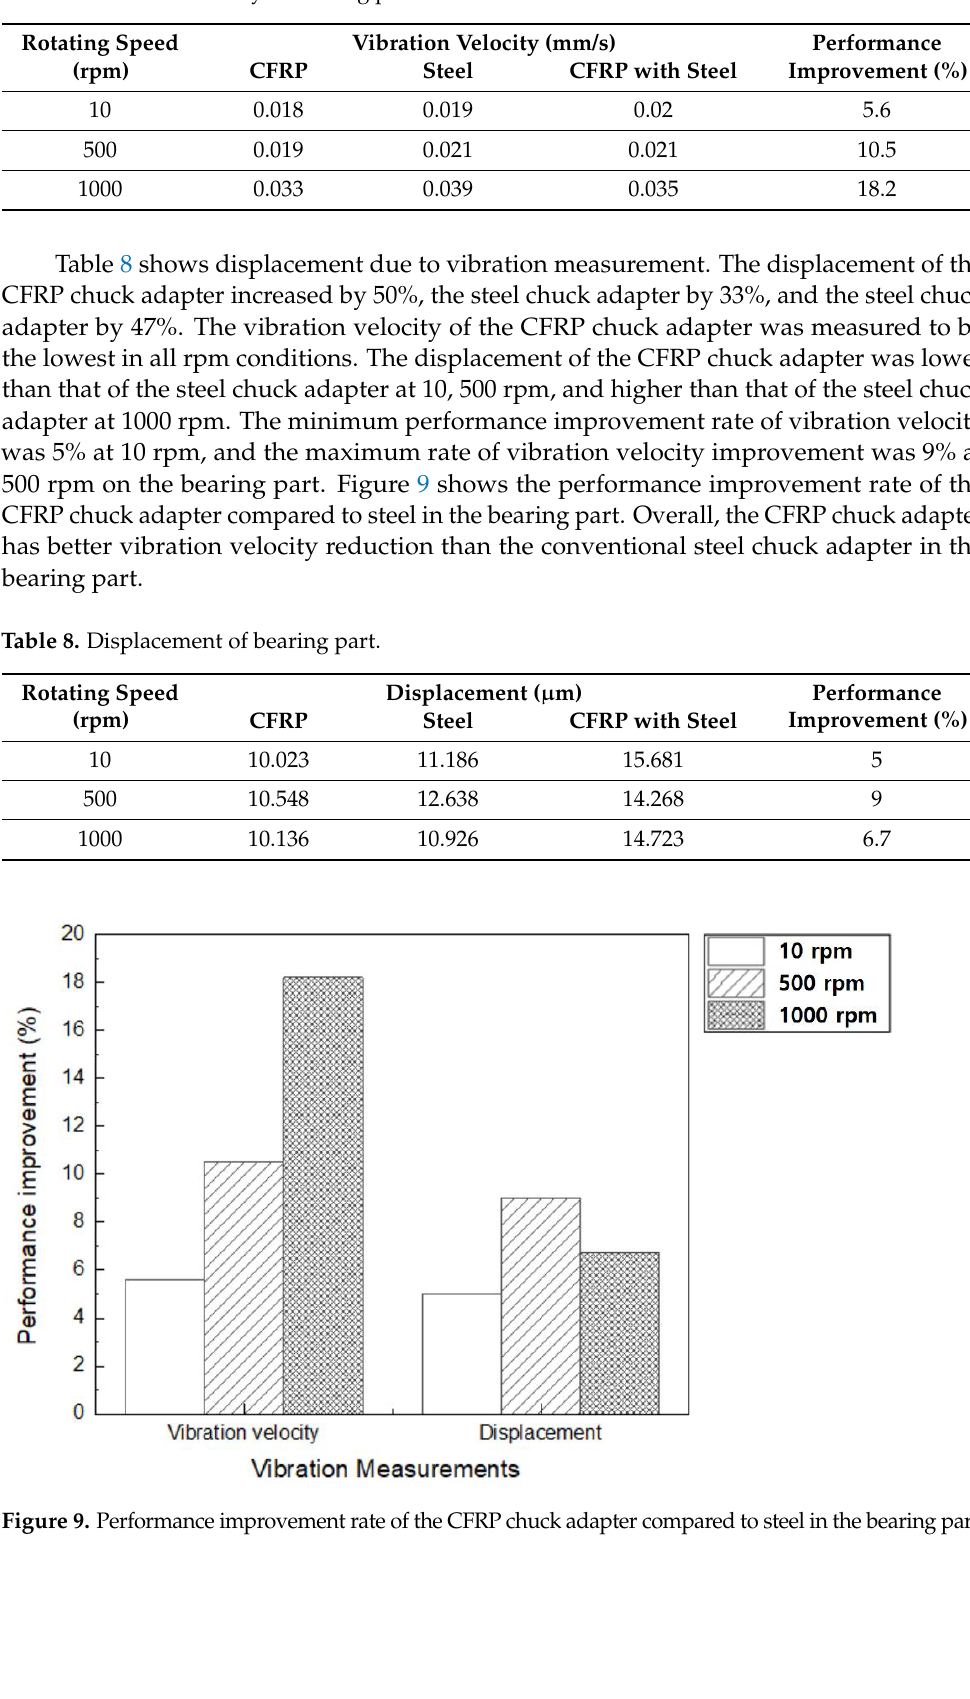
Table 7. Vibration velocity of bearing part.